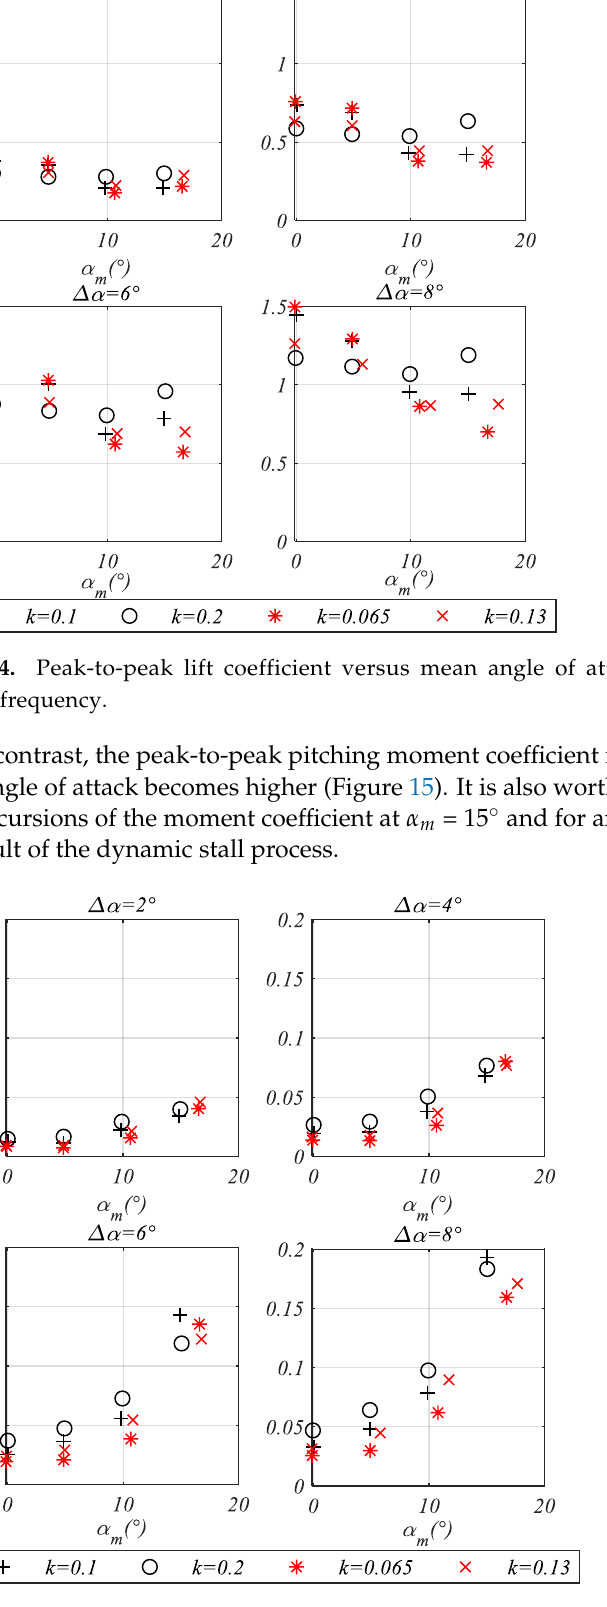
Figure 15. Peak-to-peak moment coefficient versus mean angle of attack, angle amplitude and re- duced frequency. reduced